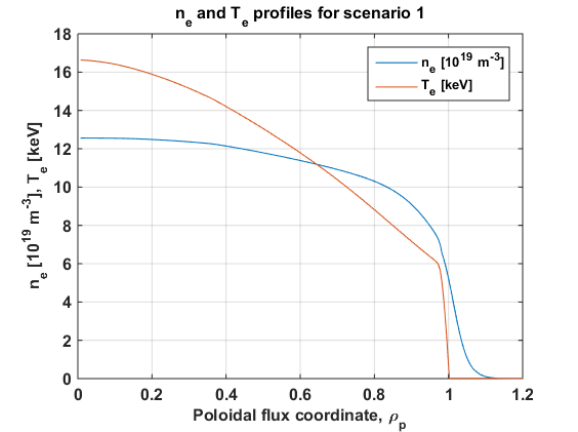
Fig. 8. Electron density and temperature profiles for the provided Scenario 1 (ITER Baseline Scenario) that was used for the ray tracing presented in Figure